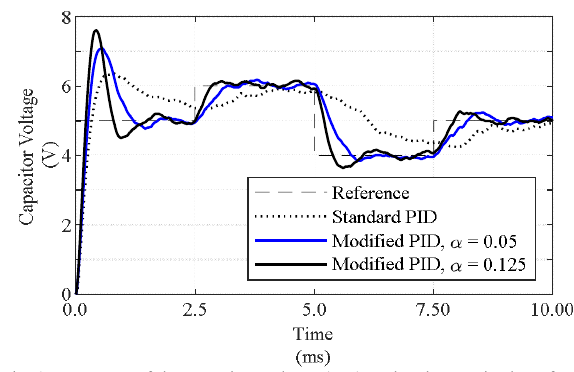
Fig. 9. Response of the capacitor voltage (